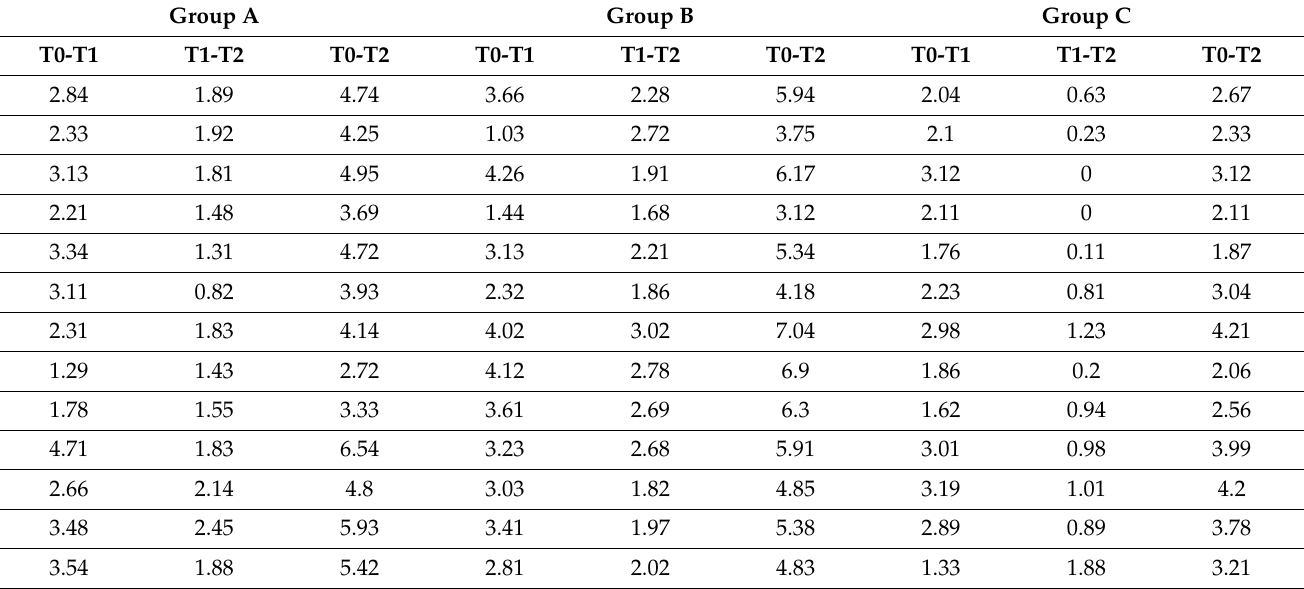
Table 1. Eruption values for Groups A, B and C in T0-T1, T1-T2,